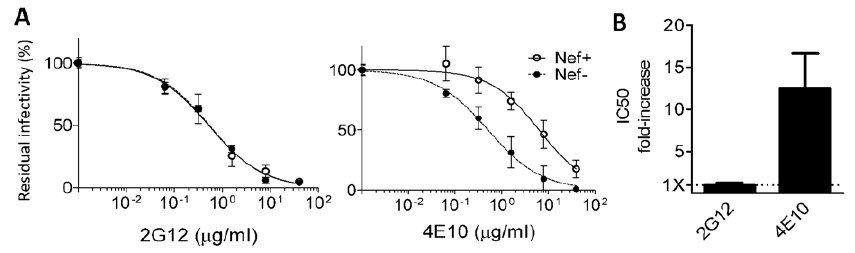
Figure 10. The effect of Nef on neutralization does not depend on the cytoplasmic tail of HIV-1 Env. Neutralization of wild type and Nef- defective HIV-1 NL4-3 virus particles pseudotyped with Env JRFL mutants lacking the cytoplasmic tail, by 2G12 and 4E10 (A). Fold-increase of IC50 caused by Nef (B). Neutralization was performed three times independently. Shown are the mean values and